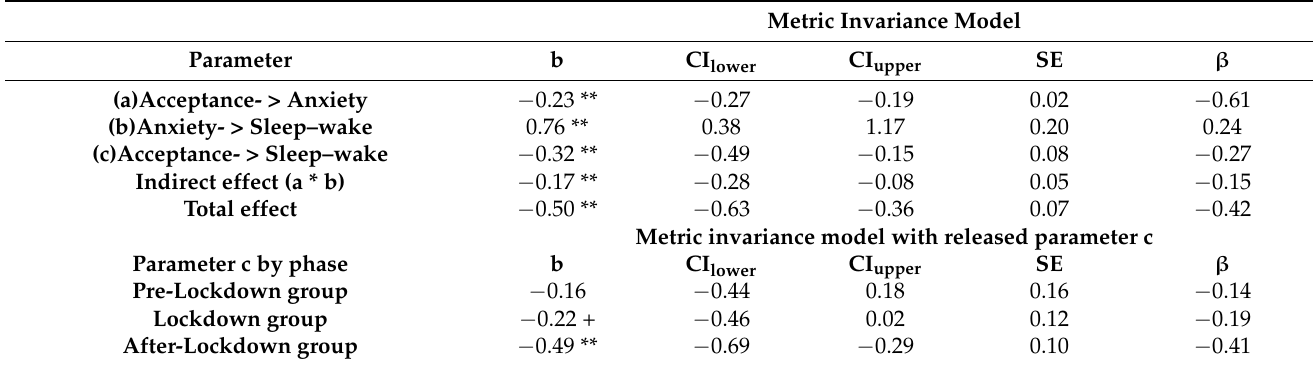
Table 3. Estimated coefficients for the metric invariance model and path c estimated in each phase in the model with the released